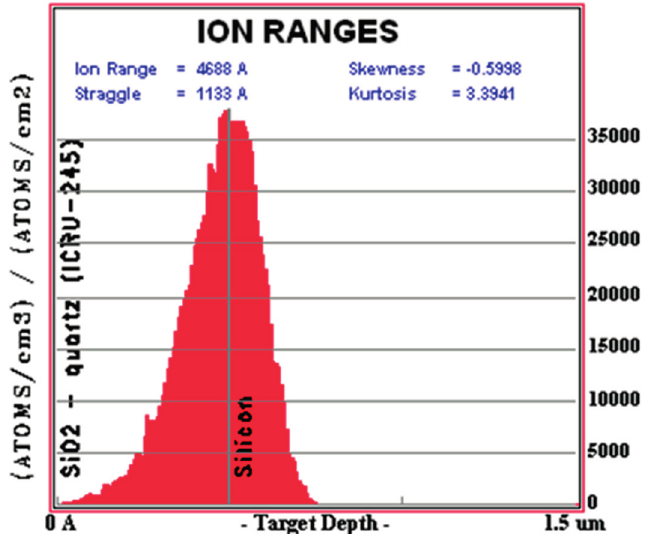
Figure 4. Simulation of hosphorous ion implantation through surface oxide using SRIM